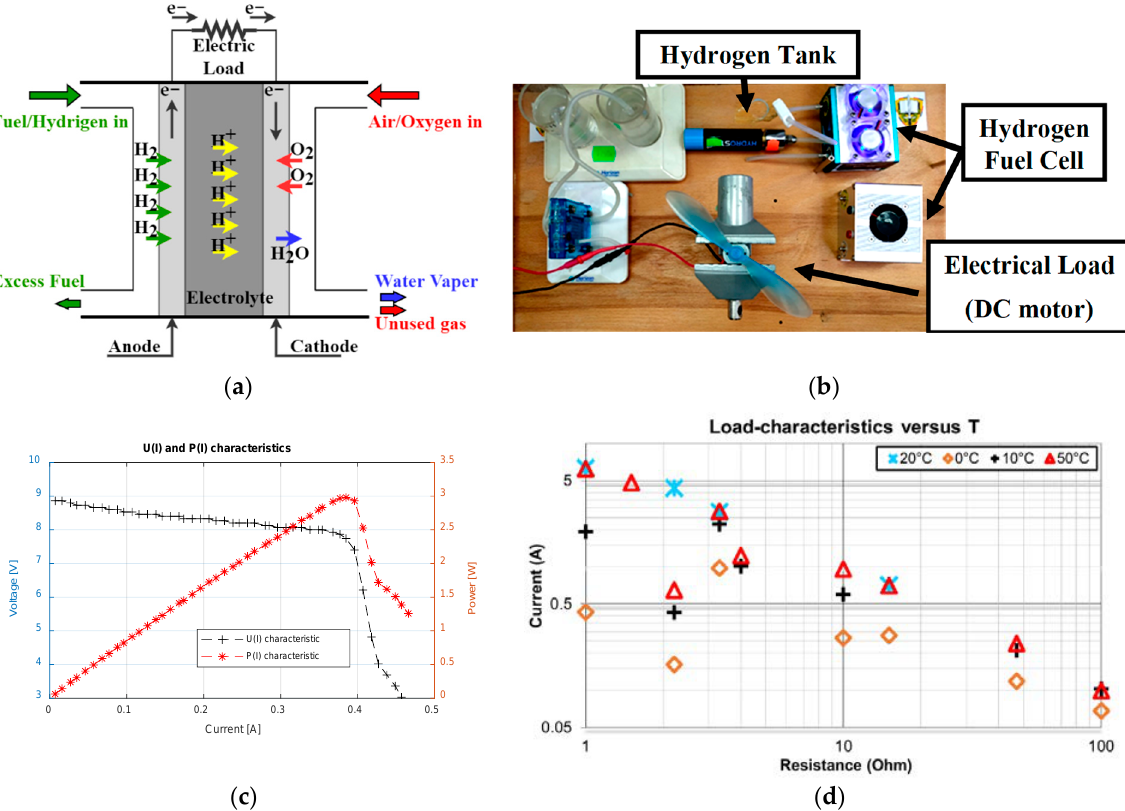
Figure 4. Hydrogen Fuel Cell system: ( a ) Structure and major components; ( b ) Hydrogen Fuel Cell system in practical; ( c ) Power characteristics of a Hydrogen Fuel Cell; ( d ) Fuel cell at various temperatures.